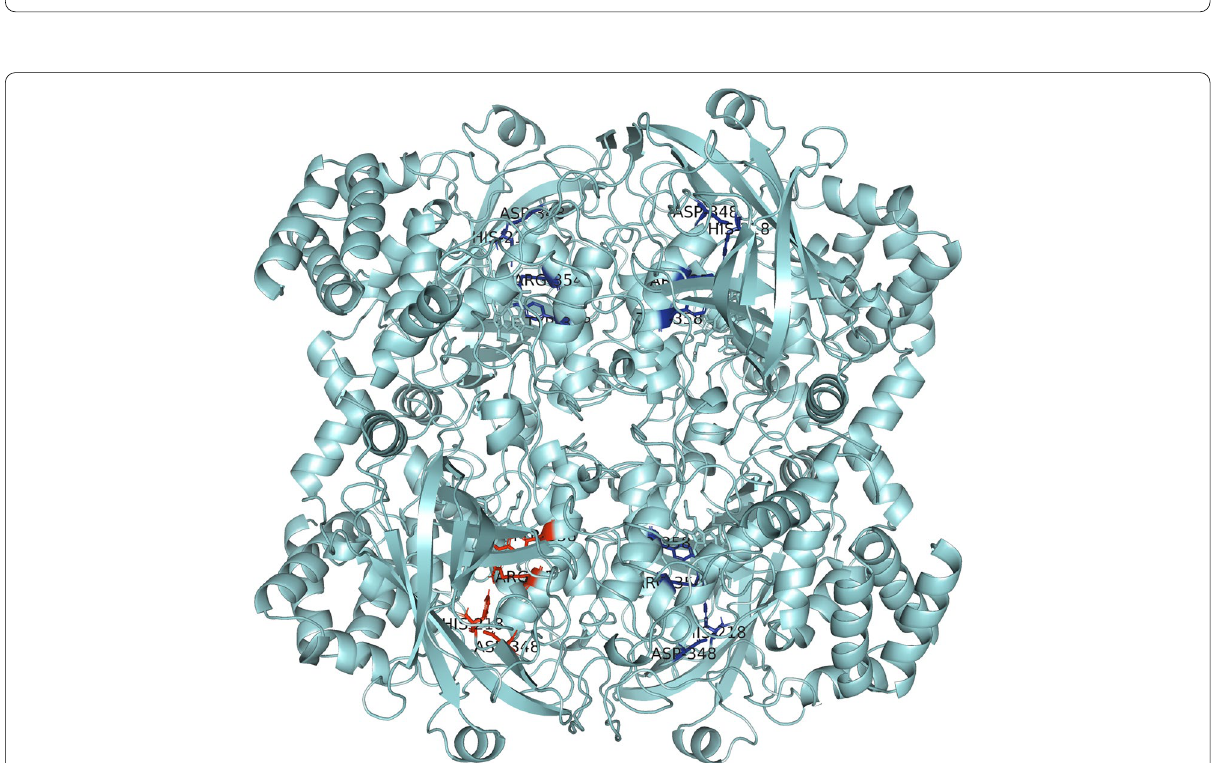
Fig. 3 Active heme centers in all catalase